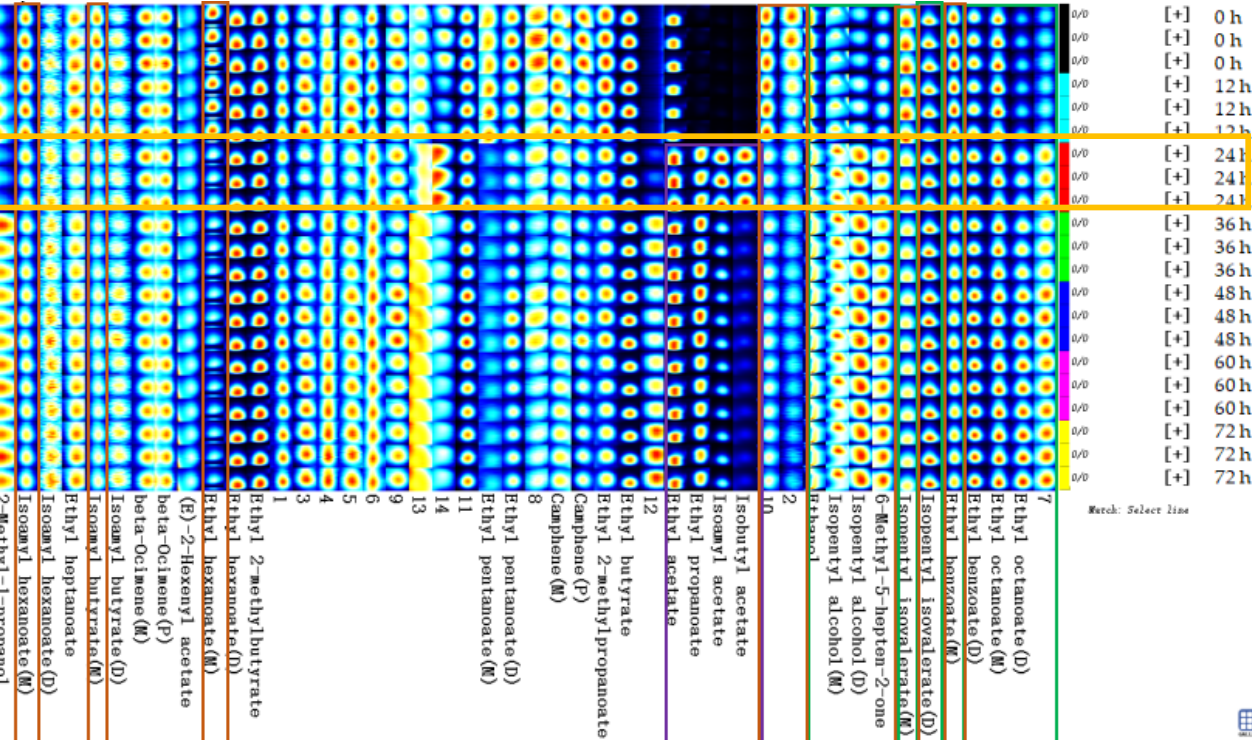
Figure 6. Fingerprints of volatile flavor compounds in the sea buckthorn juice during fermentation. Each line in the graph represented the signal peaks in a sample. Each column represented the signal peak of the same volatile substances measured in triplicate for each storage time, and the unidentified substances in samples were described by